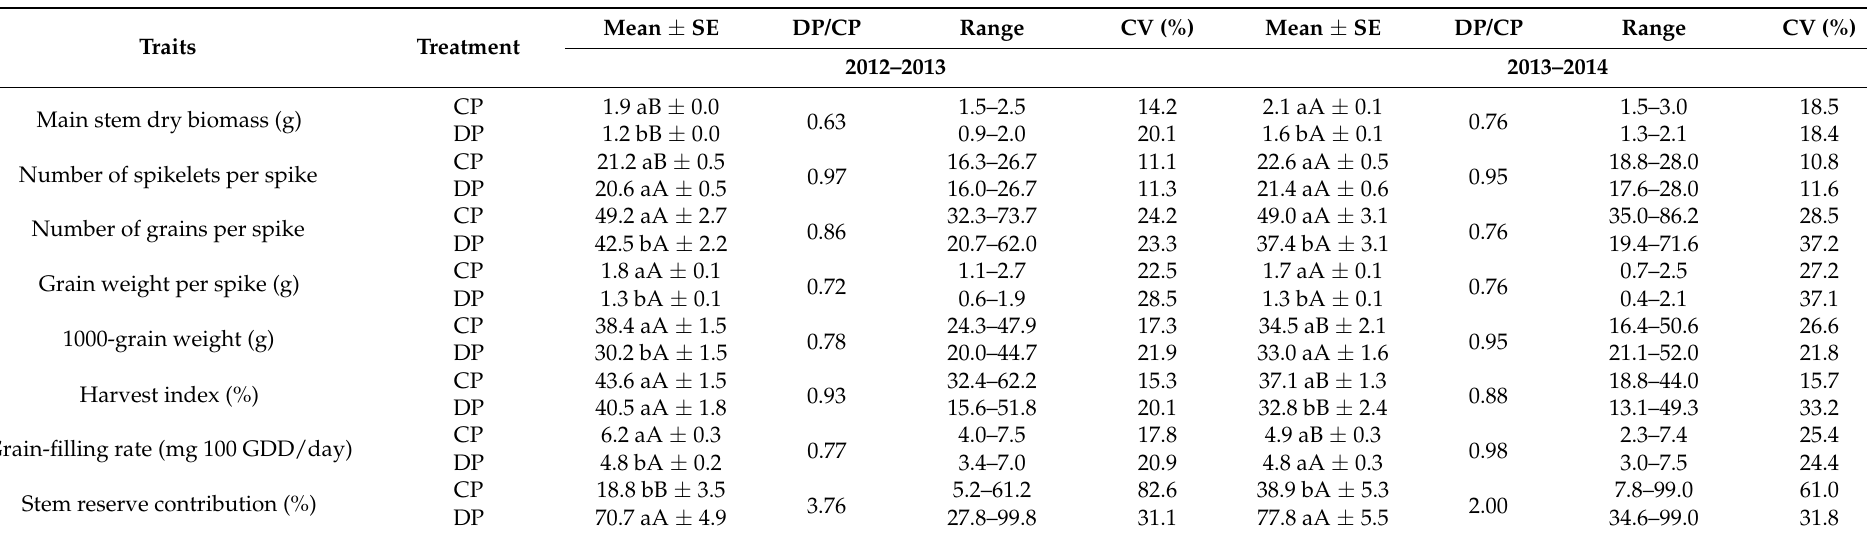
Table 5. Descriptive statistics for the agro-physiological traits for 20 wheat genotypes in control (CP) and defoliated plants (DP), during two growing